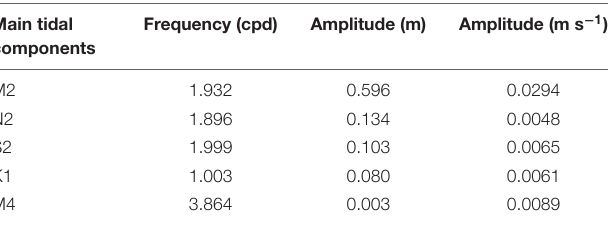
TABLE 1 | Main tidal components with their frequencys and amplitudes of pressure and velocity